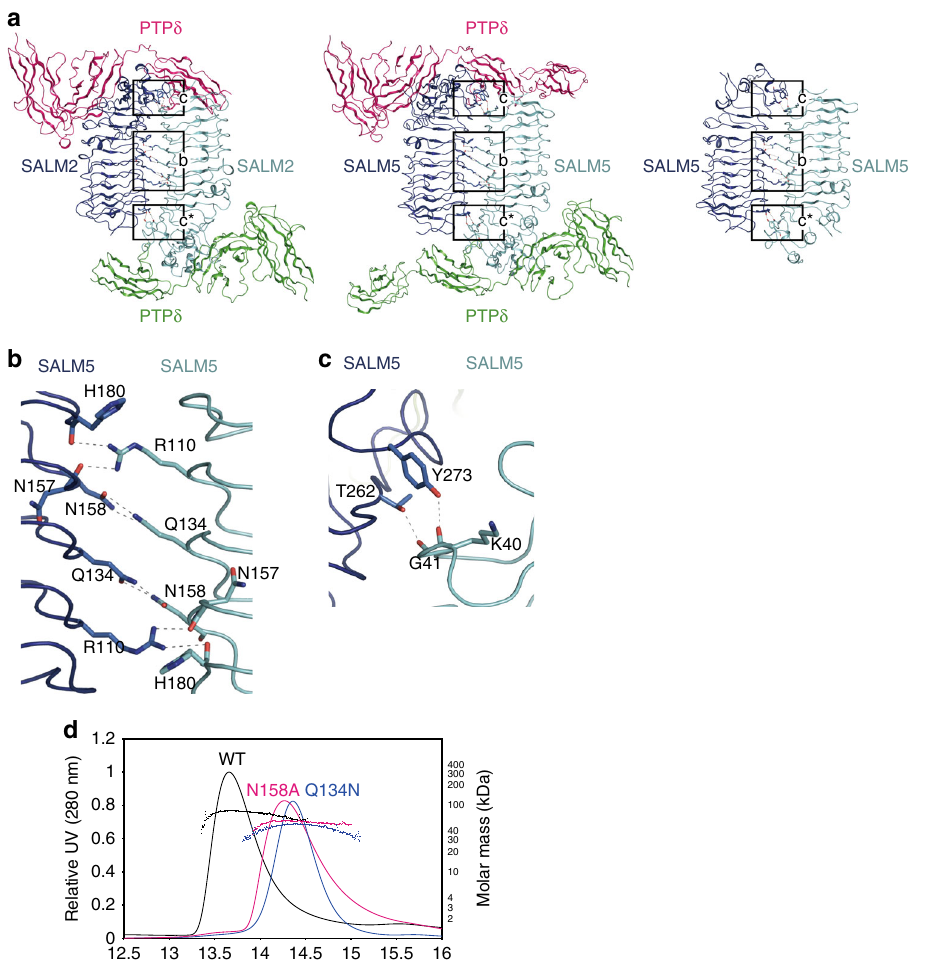
Fig. 3 LRR-mediated dimer of SALM5. a Overall views of the 2:2 complexes of PTP δ – SALM2 and PTP δ – SALM5 and the dimer of apo SALM5. The central and peripheral regions of the dimer interface are enclosed by the rectangles labeled ‘ b ’ and ‘ c ’ , respectively. The details are shown in b and c , as indicated. The regions ‘ c ’ and ‘ c* ’ are related by pseudo- C 2 (PTP δ – SALM2 and PTP δ – SALM5) or C 2 (apo-SALM5) symmetry. b Interactions in the central region of the SALM5 dimer interface. Hydrogen bonds are indicated as dotted lines. c Interactions in the peripheral region of the SALM5 dimer interface. Hydrogen bonds are indicated as dotted lines. d SEC-MALS analyses of wild type and N158A and Q134N mutants of SALM5 LRR – Ig (black, magenta, and blue, respectively). The plotted dots that look like dotted lines correspond to the calculated molar masses of each